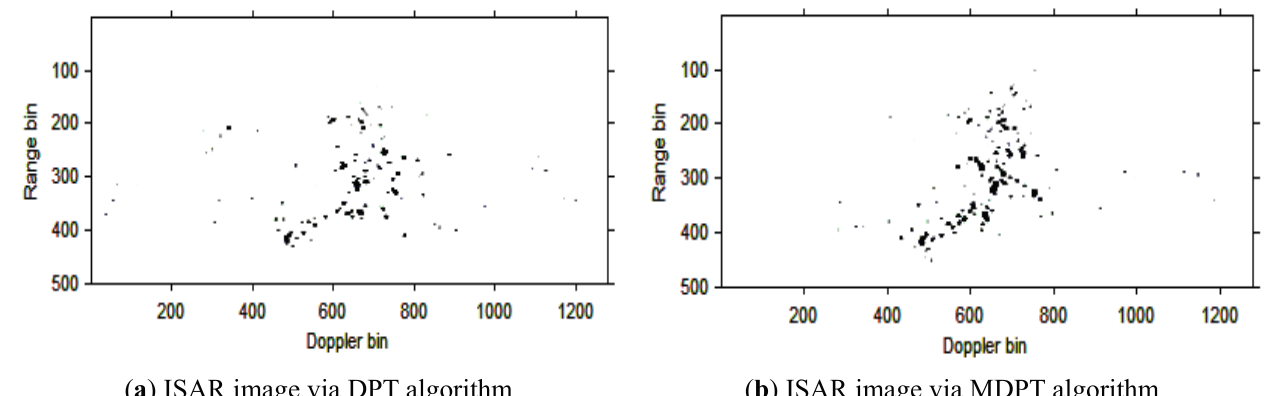
Figure 8. ISAR images at time t = 0.90 s based on DPT and MDPT